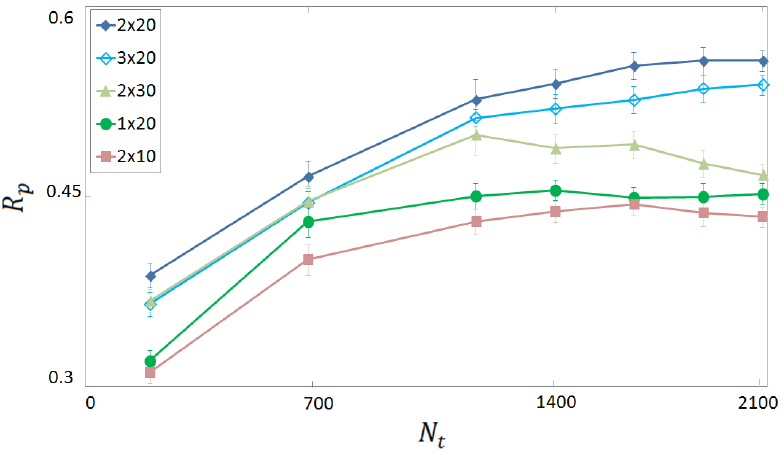
Figure 2. R p score for binding affinity prediction as a function of the size N t of the (experimental) training set. Each dataset corresponds to a choice N l × N h for the number of hidden layers N l and of neurons per layer N h in the fully connected neural network (FCNN). The complex representation includes N d = 60 descriptors, with four distance intervals of width